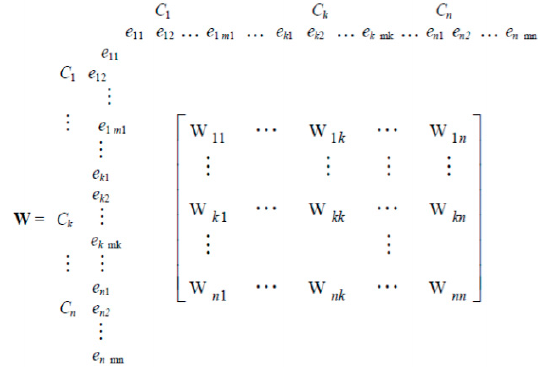
Figure 6. The super matrix representing an ANP model.